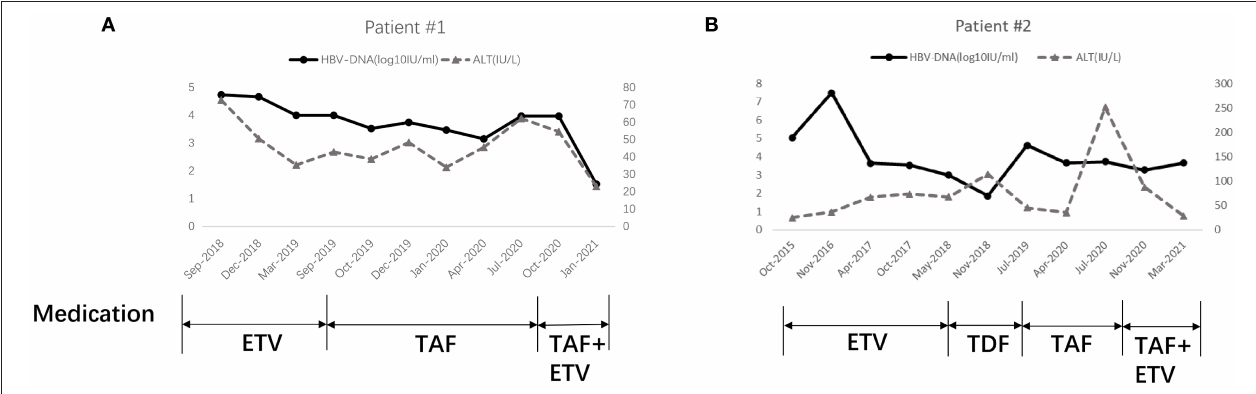
FIGURE 1 | Clinical course of Patient 1# (A) and Patient 2# (B) . ETV, Entecavir; TDF, Tenofovir disoproxil fumarate; TAF, Tenofovir